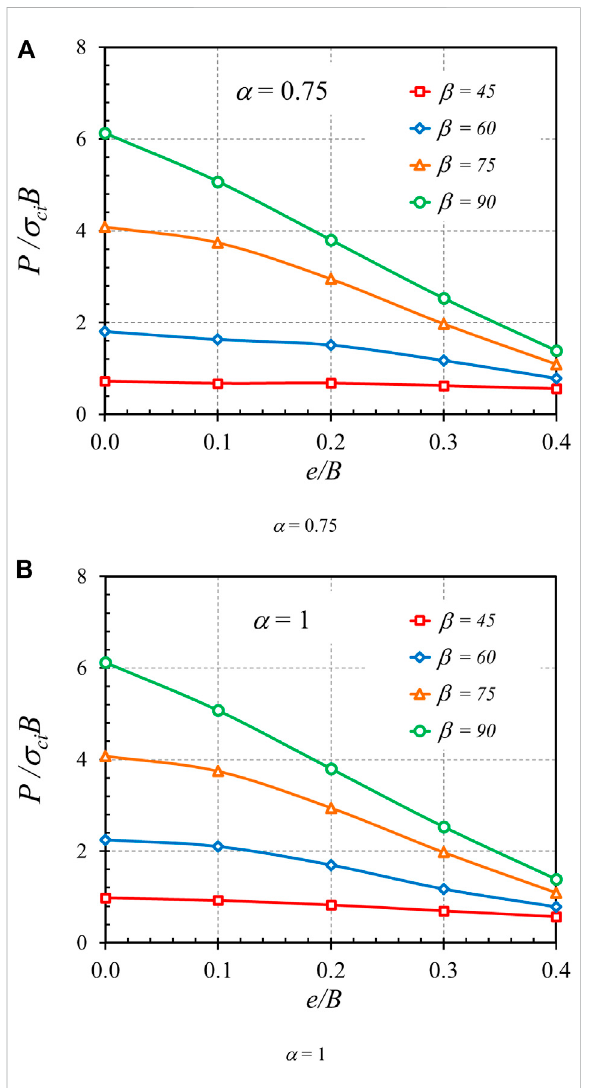
FIGURE 12 In fl uence of load inclination, β on the stability solutions of bearingcapacityfactorontherockmass( GSI=100 , γ B/ σ ci =0,and m i = 5). (A) e/B = 0 (B) e/B =